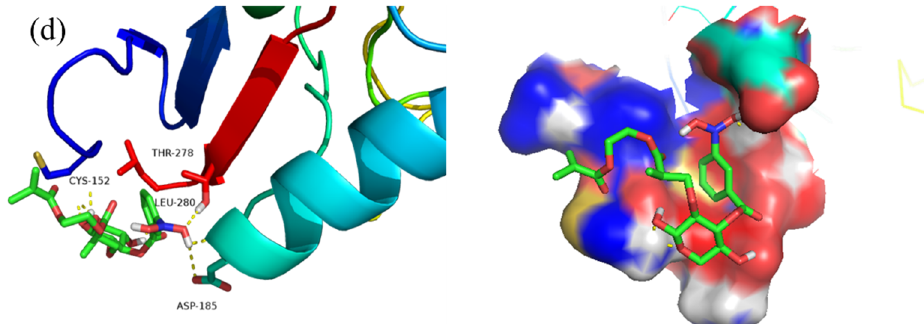
Figure 9. ( a ) The docking conformation figure of 3-CBA-BX/Res-g-EGDMA and 2HE7. ( b ) The docking conformation figure of 3-CBA-BX/Res-g-EGDMA and 5JQI. ( c ) The docking conformation figure of 3-CBA-BX/Res-g-EGDMA and 5ZSY. ( d ) The docking conformation figure of 3-CBA-BX/Res-g-EGDMA and 6YAU.